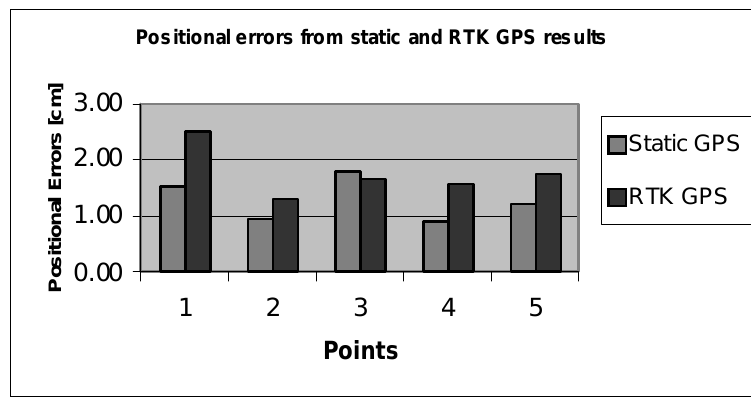
Figure 7. Positional errors from Static and RTK GPS results Positional errors from static and RTK GPS results